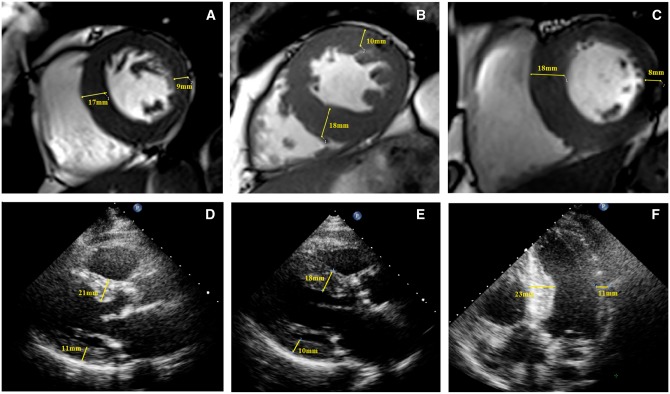
Asymmetrical wall thickening on both magnetic resonance and echocardiography. Images demonstrating asymmetric wall thickening in patients with aortic stenosis. Cardiovascular magnetic resonance short-axis cine images showing an abnormally thickened septum: in a patient with asymmetric remodelling (A) and two subjects with asymmetric hypertrophy (B) and (C). Echocardiographic parasternal long-axis images demonstrating thickening of the septum in two further patients with asymmetric remodelling (D) and (E). Echocardiographic apical 4-chamber image in a subject with asymmetric hypertrophy (F).